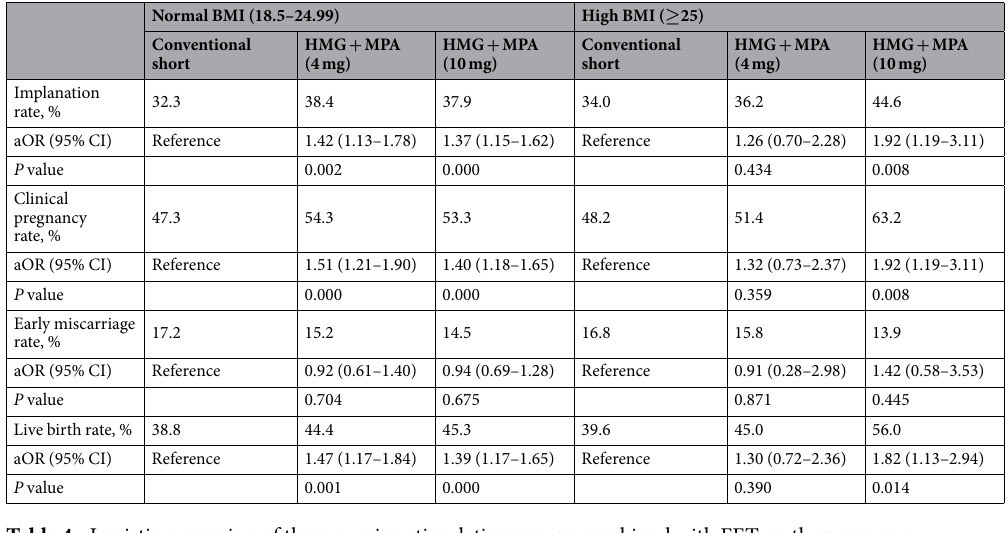
Table 4. Logistic regression of three ovarian stimulation groups combined with FET on the pregnancy outcomes according to female BMIs. After adjusting for female age, duration of infertility, basic serum FSH level, the E2, P level and endometrial thickness on the FET day, and the number of embryos transferred, binary logistic regression was performed. The differences were considered statistically significant when the p-value was less than